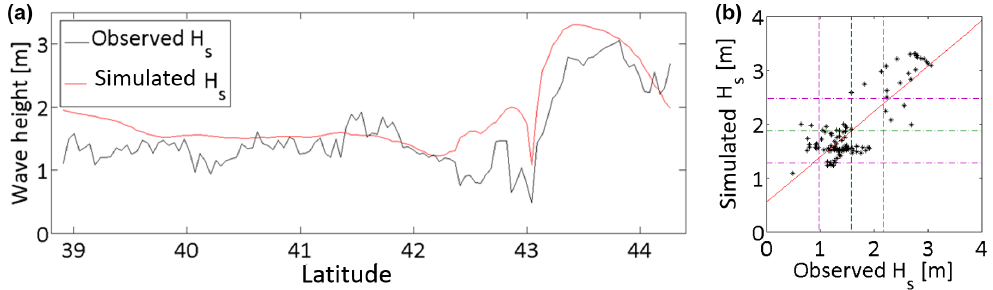
Figure 8. Matching between WW3 and Ku-band altimeter data from the JASON-2 satellite pass 44 cycle 280. (a) Time series during the period from 9 February 2016 at 04:58:44 to 05:00:43UTC. (b) Scatter diagram between observed and simulated H s (m). The green dotted lines are the mean in the x (1.876) and y (1.574) directions, while the purple dotted lines are the relative standard deviation of 0.6022 and 0.5975.